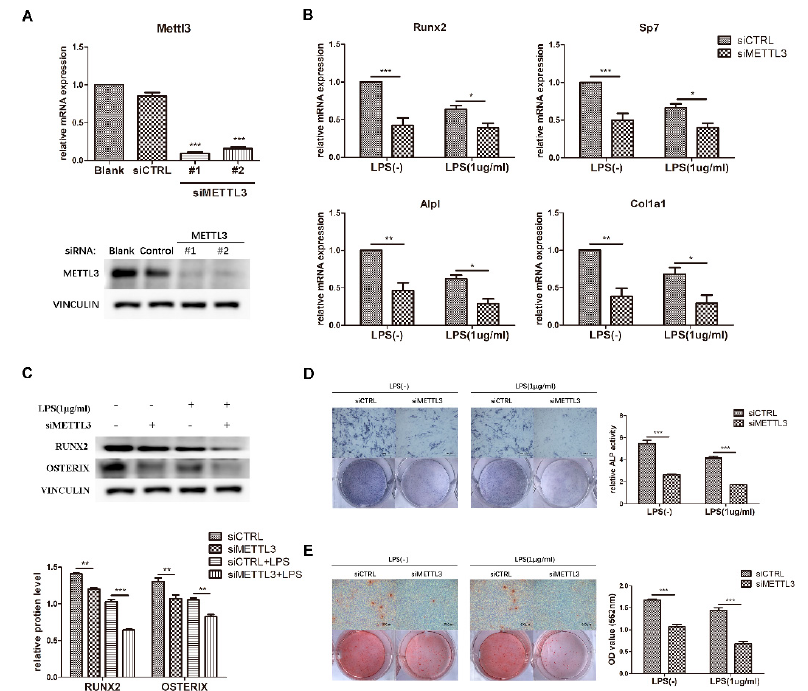
Figure 3. Effect of METTL3 knockdown on osteoblast differentiation. ( A ) The transfection efficiency of METTL3 knockdown was determined by qRT-PCR and western blotting. Blank, cells transfected with growth medium; siCTRL, cells transfected with negative control siRNA; siMETTL3, cells transfected with METTL3 siRNA. ( B , C ) MC3T3-E1 cells were transfected with siRNA (METTL3 or negative control) for 12 h and then treated with osteogenic induction medium with or without 1 µ g / mL LPS for 60 h. The mRNA expression of Runx2 , Sp7 , Alpl , and Col1a1 was measured by qRT-PCR ( B ). GAPDH was used as a normalization control. The protein levels of RUNX2 and OSTERIX were assessed by western blotting ( C ). VINCULIN was used as an internal control. The band intensities were quantified using ImageJ software. ( D ) The ALP activity of siCTRL or siMETTL3 cells undergoing osteogenic induction with or